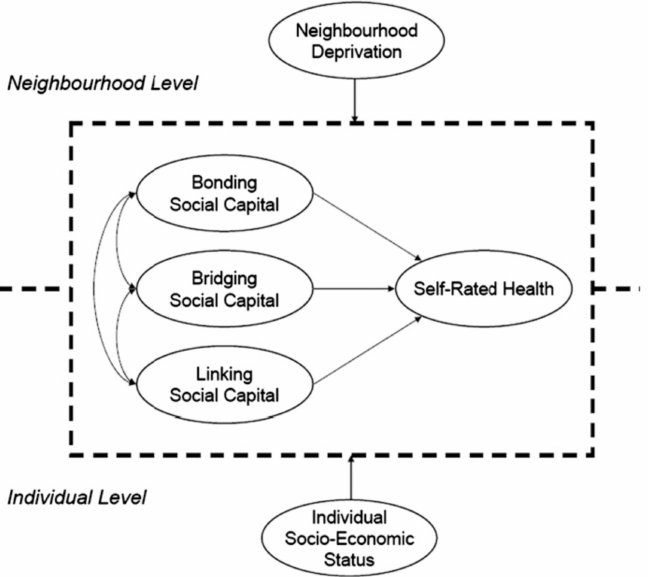
Figure 5. Social capital as determinants of health. Reproduced with permission from Israel, B.A., Social networks and health status: Linking theory, research, and practice; Published by Patient Counselling and Health Education,